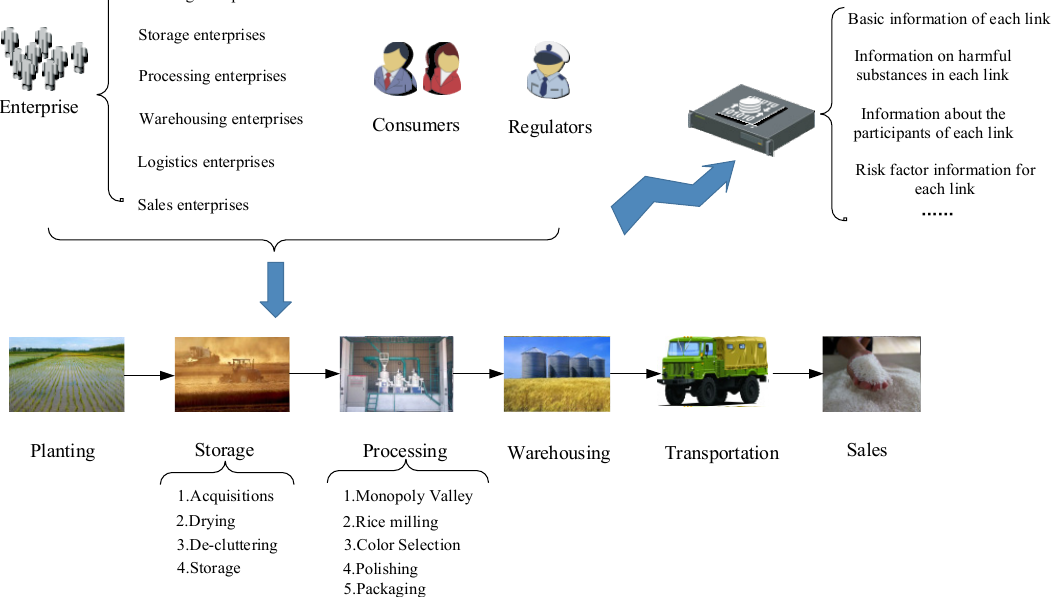
Figure 1. Basic structure of the rice supply chain.